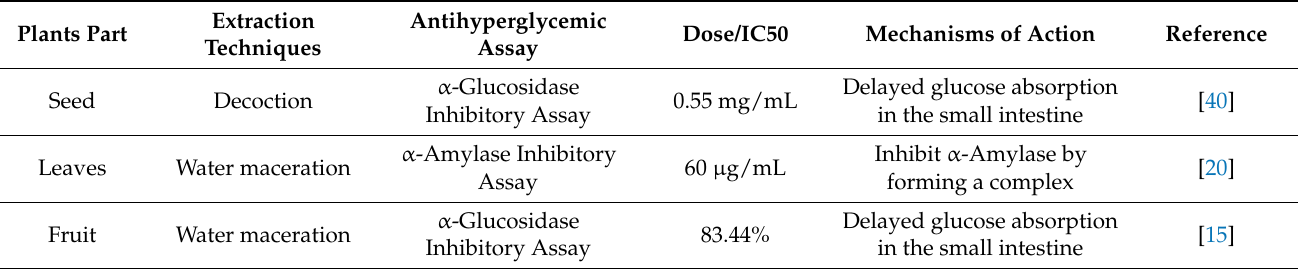
Table 3. Antihyperglycemic activity of B. macrophylla